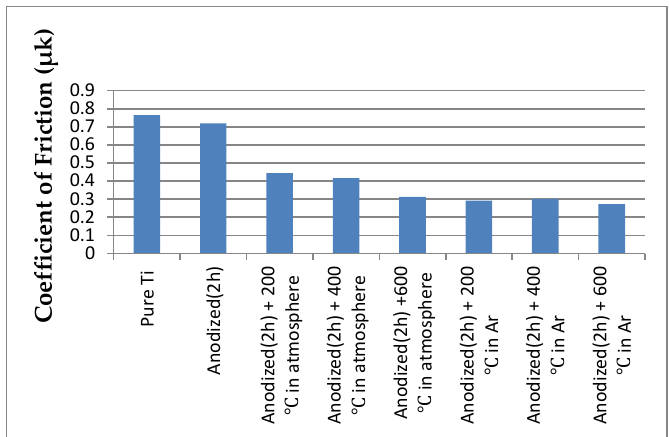
Figure 8. The friction coefficients of TiO 2 coatings before and after heat treatment at different temperatures and different atmospheres.